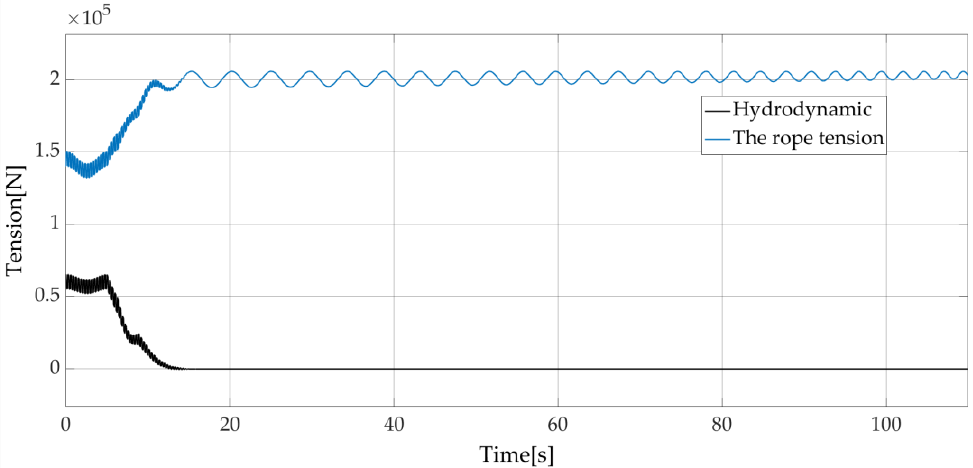
Figure 24. L = 27 m, V = − 0.2 m/s, rope tension and hydrodynamic forces on the load with wave